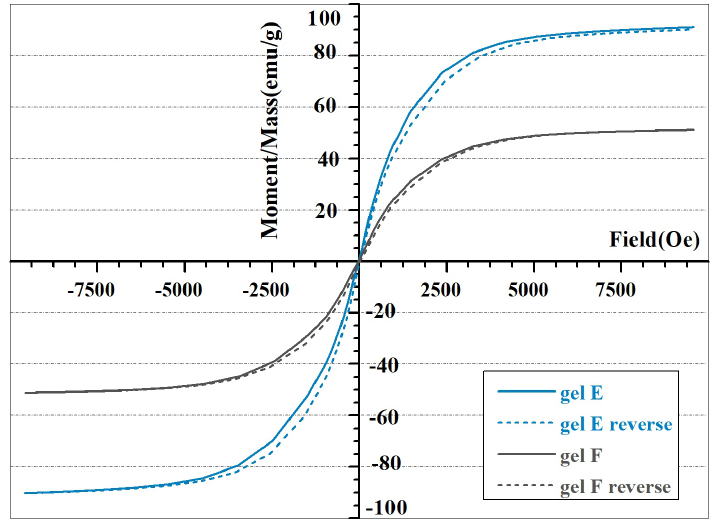
Figure 11. Magnetization hysteresis curves of Schiff base cross-linked HA gels containing 30%